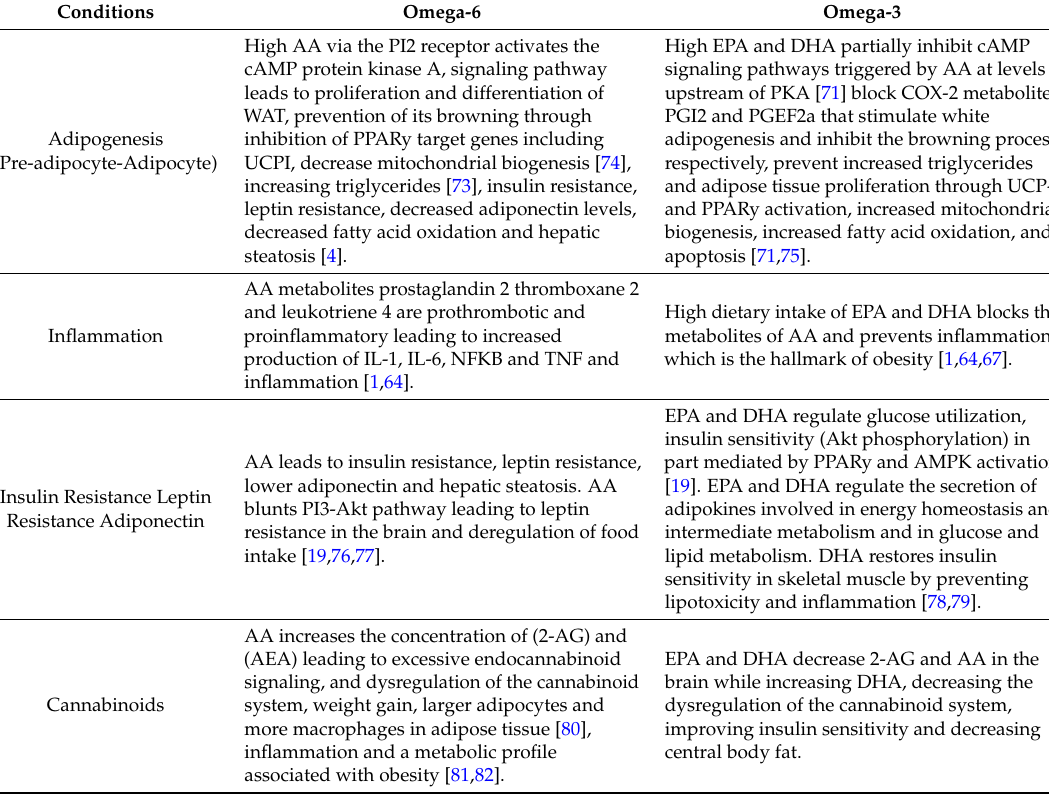
Table 5. Opposing Effects of Omega-6 and Omega-3 Fatty Acids in